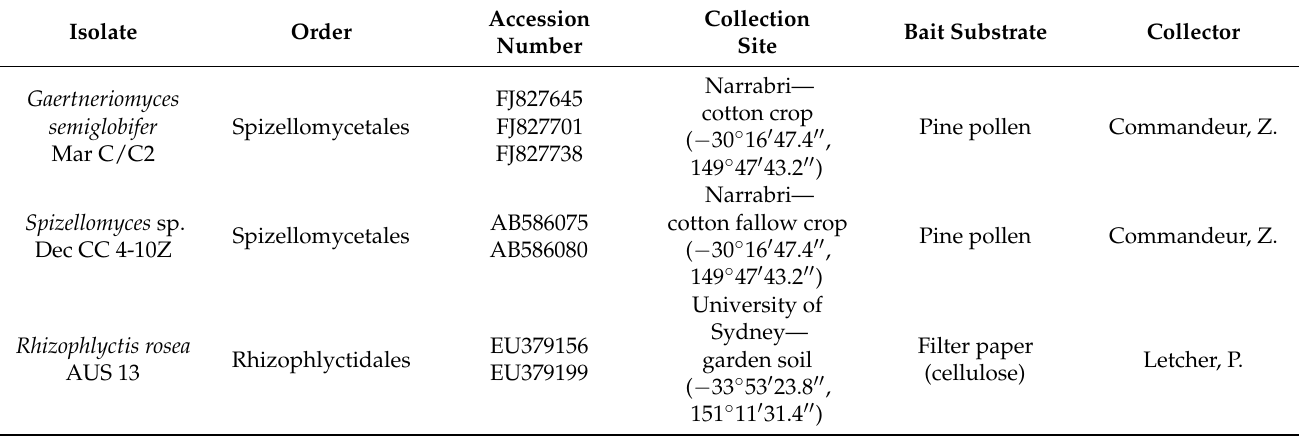
Table 1. Chytrid strains selected for experimental investigation. Isolates were previously collected from sites in New South Wales. Initial identification was performed using morphological charac- terisation and later recorded in GenBank with partial 18s rRNA sequences [7,8]. Stock cultures are maintained on solid and liquid complex peptone, yeast and glucose (PYG) medium (2.5 mM